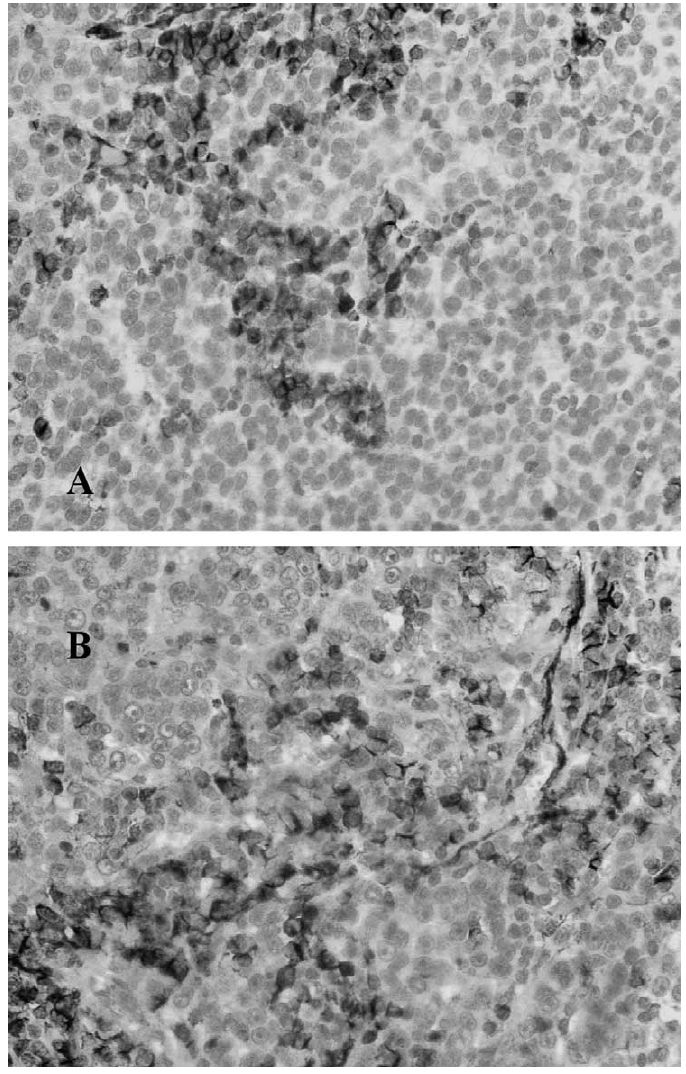
Fig. 3. CD31 immunoreactivity in metastatic melanoma: canalicular pattern (Original magnification × 400).